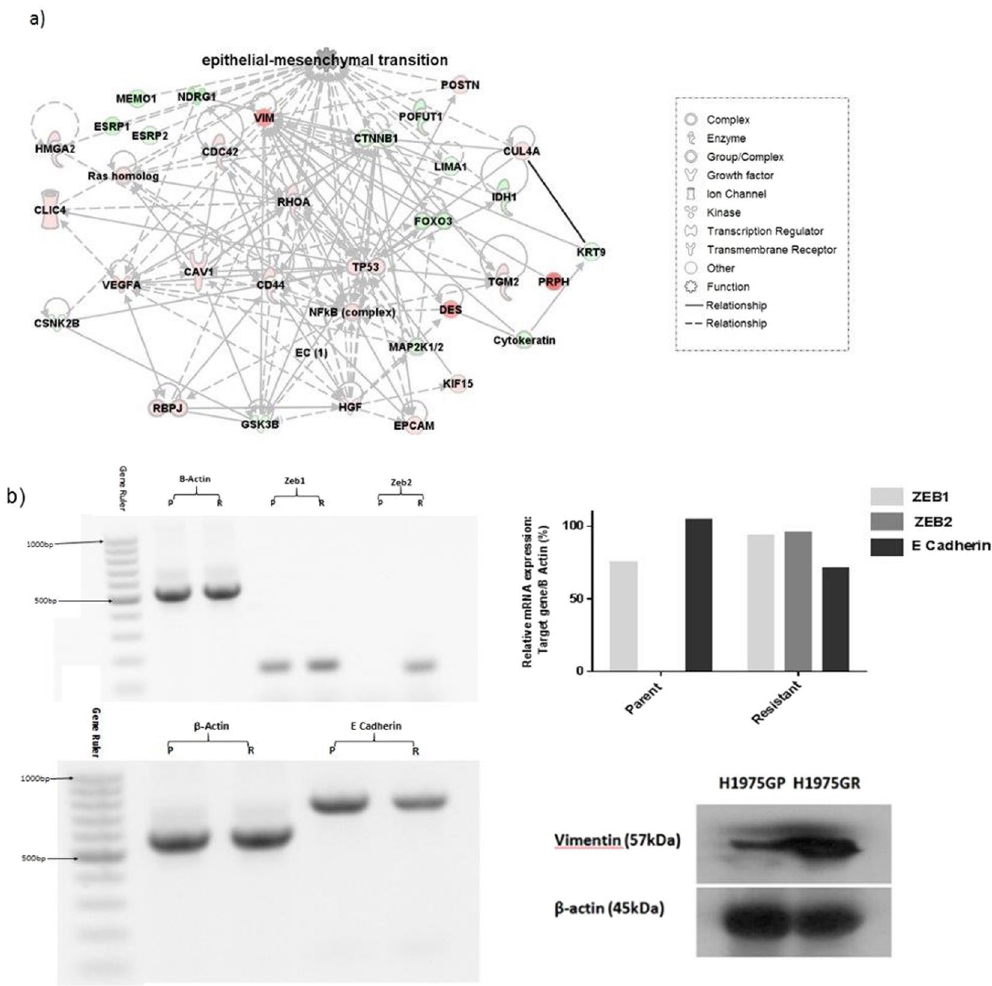
Figure 6. Dysregulation of EMT in GDC-0980 resistant cells. ( a )H1975PT and H1975GR cells were analysed by bottoms-up label-free mass spectrometry in Fig. 4. Ingenuity pathway analysis revealed significant (p < 0.05) dysregulation in a number of proteins involved in EMT, (red = upregulation, green = downregulation). ( b ) PCR and Western blotting was carried out in order to validate the EMT dysregulation identified by mass spectrometry in part a. PCR data showed downregulation of E-cadherin and upregulation of Zeb1 & Zeb2 mRNA expression in H1975GR vs H1975GP. Western blot analysis showed elevated vimentin